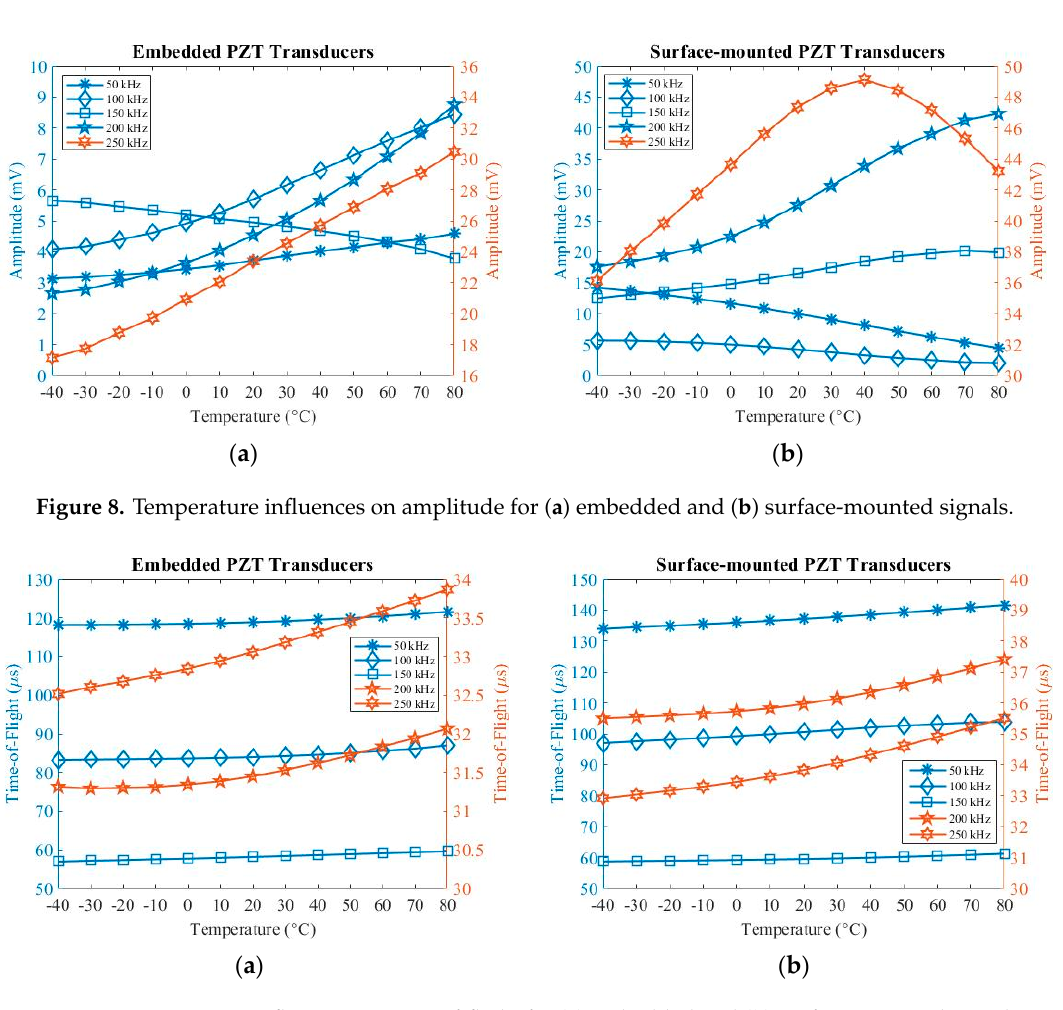
Figure 9. Temperature influences on time ‐ of ‐ flight for ( a ) embedded and ( b ) surface ‐ mounted signals.